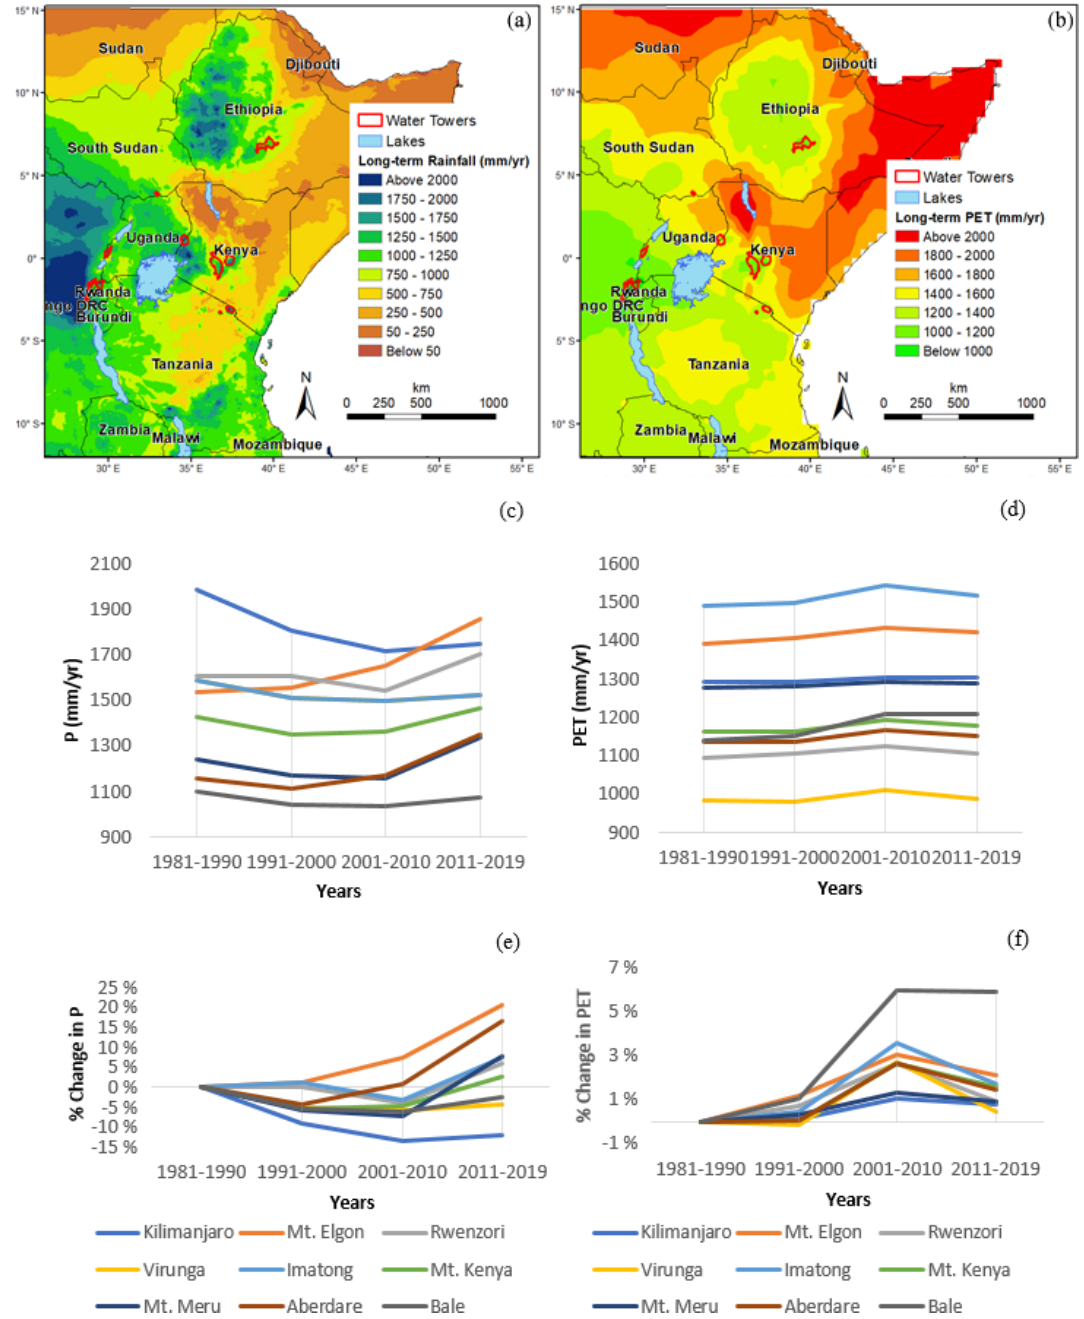
Figure 2. Long-term mean annual rainfall and potential evapotranspiration. The left panels show the precipitation and the observed changes for the period 1981–2019 (a, c, e) . The right panels show potential evapotranspiration and the observed changes for the period 1981–2019 (b, d, f)